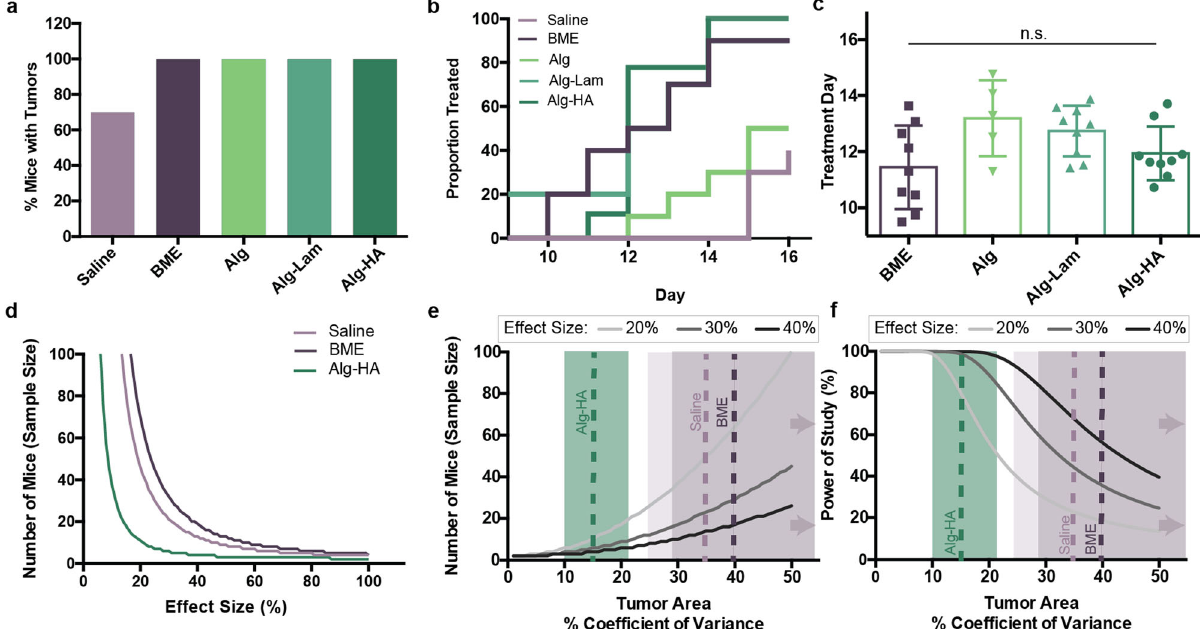
Fig. 3 Statistical evaluation of tumor growth, treatment, and power. a Percentage of mice that formed palpable tumors during the 15-day experiment. b Treatment day analysis from interpolation assuming exponential growth. Proportion treated from each group over time. c Individual points (representing each mouse ’ s treatment day) plotted with average and standard deviation. d Power analysis predicting the number of mice per group needed based off